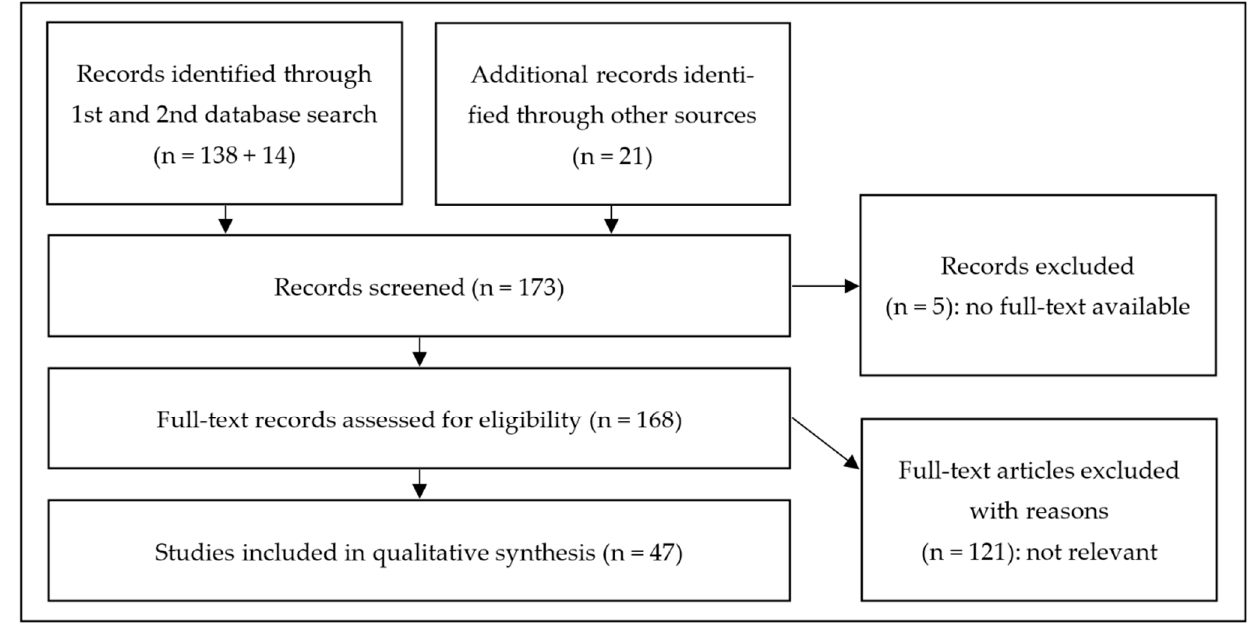
Figure 1. Methodical approach of our review according to PRISMA criteria.